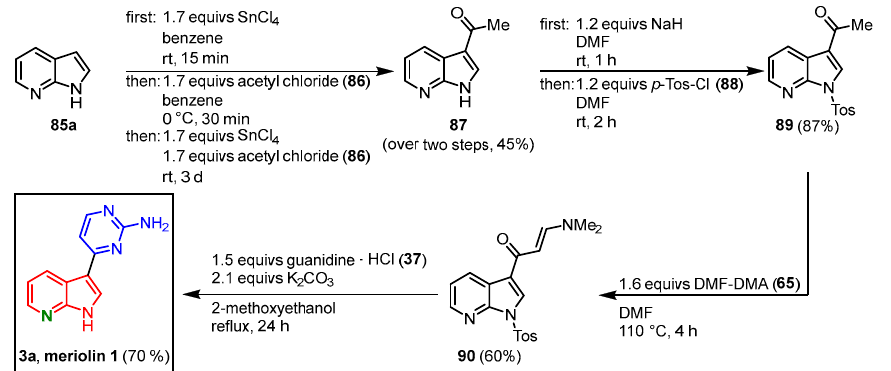
Figure 21. Synthesis of meriolin 1 by Molina and Fresneda